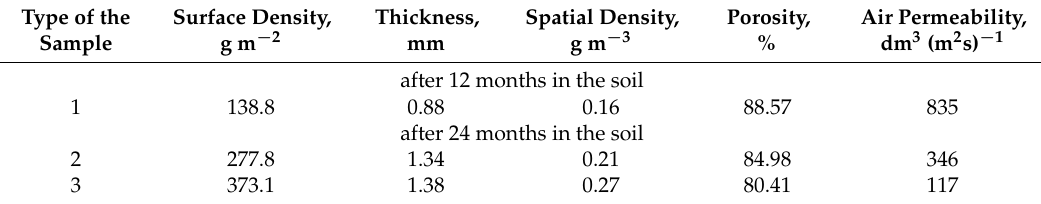
Table 3. Value of geotextile nonwoven materials indicators after